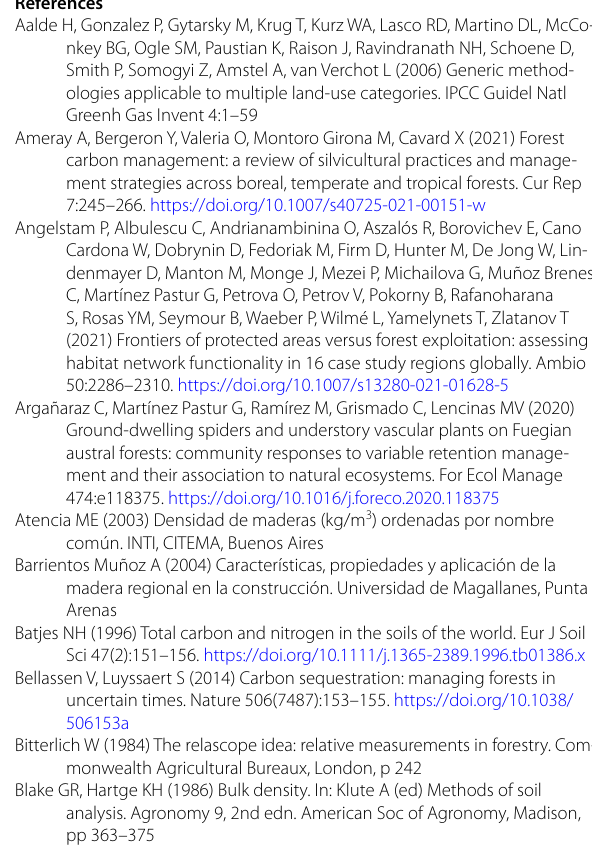
Table 1. Appendix 4. Fisher test ( F ) and probability ( p ) of analyses of variance for carbon contents (t C ha − 1 ) comparing primary unmanaged forests (PF) and retention types (AG persed retention), and variable retention harvested stands (VRH)